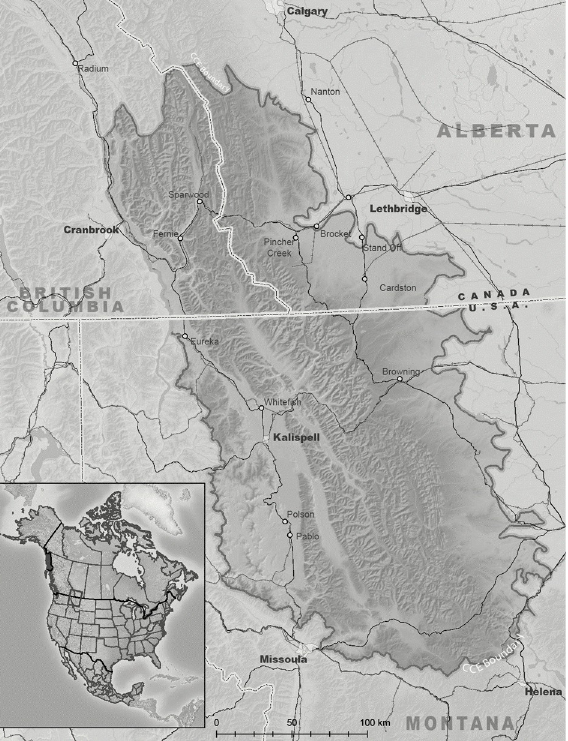
Fig 1. The Crown of the Continent study area. Map source is the Crown Managers Partnership data archive on the USGS Sciencebase data site: https://www.sciencebase.gov/catalog/item/51102e04e4b048b5cead853b.